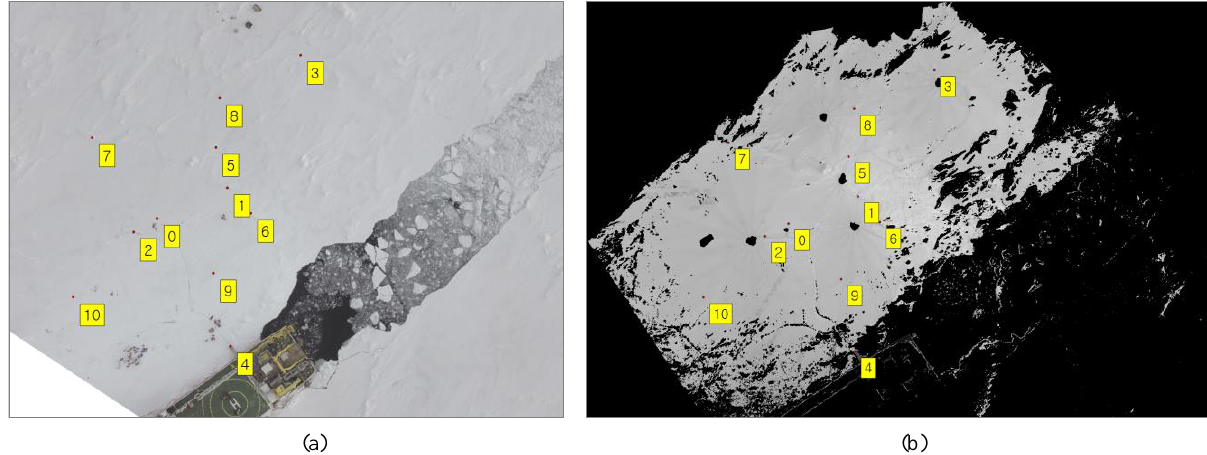
Figure 4. Tiepoints extracted for registration between the UAV DSM and the scanner DSM. (a) ortho-mosaic image for the UAV images and (b) ortho-mosaic image for the scanning data.